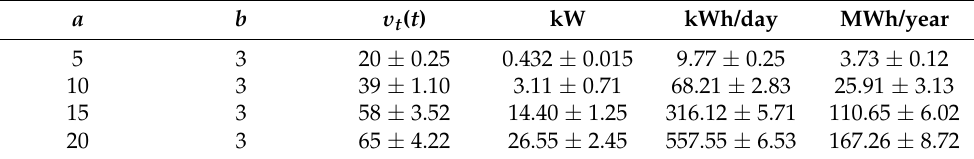
Figure 8. Overall power output results per annual period. Table 1. Numerical results of the power generated for different chamber dimensions considering the mean values of wave height and period.